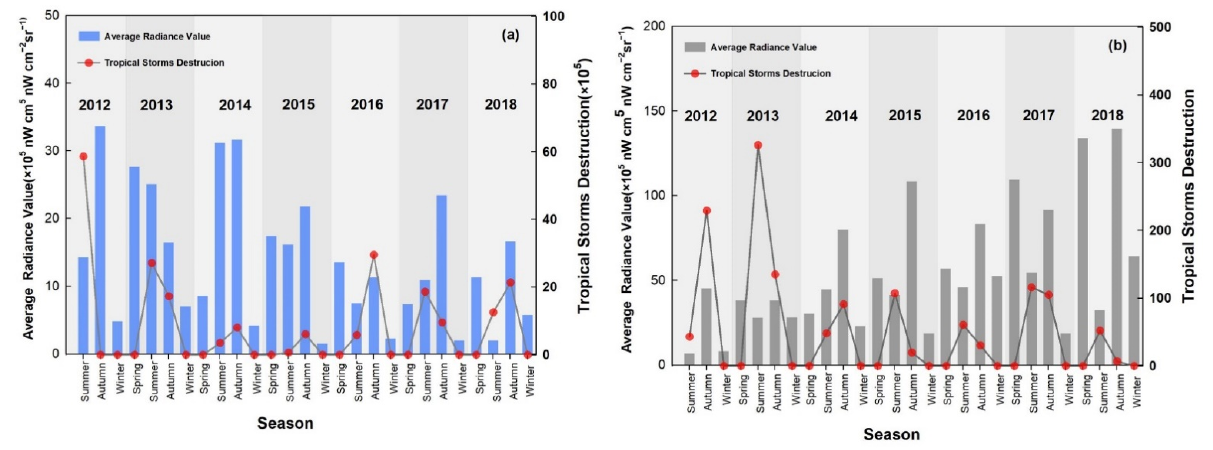
Figure 17. Fishing activity and tropical storms destruction potential in ( a ) area A ( b ) area B.